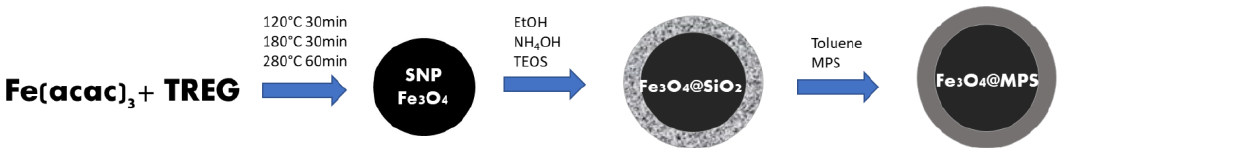
Figure 1. A schematic diagram illustrating the synthesis of the magnetite superparamagnetic nanoparticles (SNP) along with the stabilization and silanization processes.